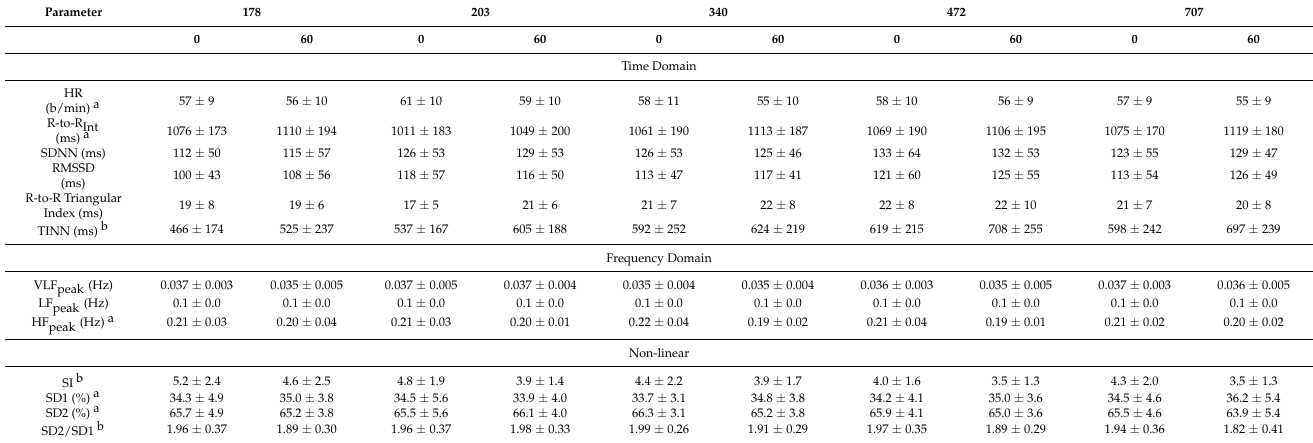
Table 4. Heart rate variability prior to and 60 min following 30 mg cannabidiol